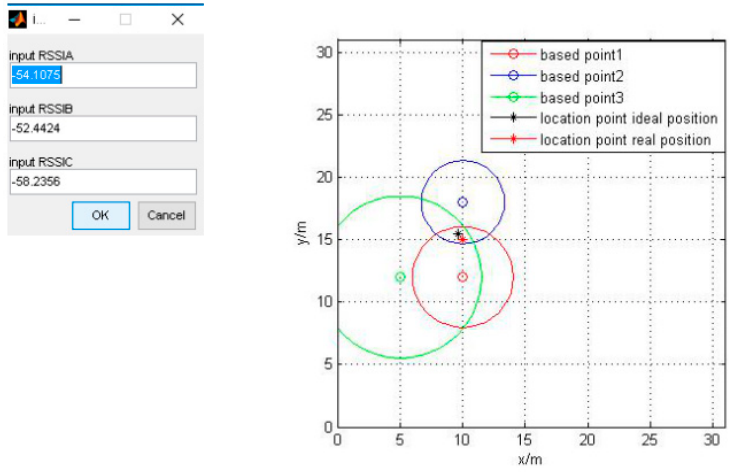
Figure 7. Simulation result when the RSSI values are − 54.1075, − 52.4424, and − 58.2356 (dBm) for the three points (a, b, and c).